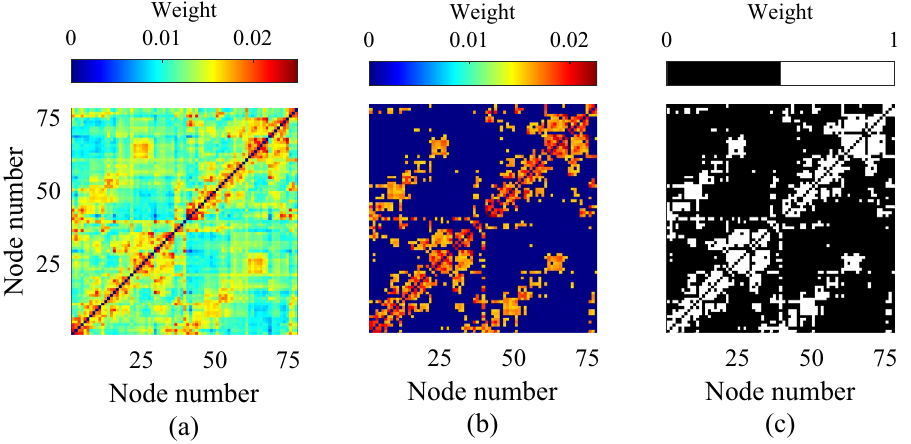
Figure 1. The structural matrix ( a ) is derived from DTI data taken from the Human Connectome Project and parcellated on to a 78–region brain atlas. This is thresholded to keep the top 23% strongest connections ( b ) and binarised by setting all retained edge strengths to unity in ( c